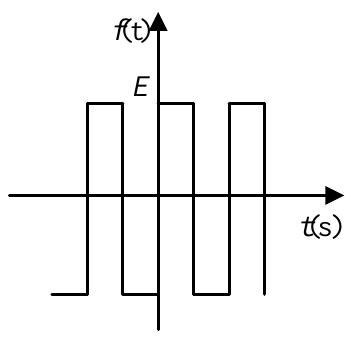
Figure 8. Square wave signal.